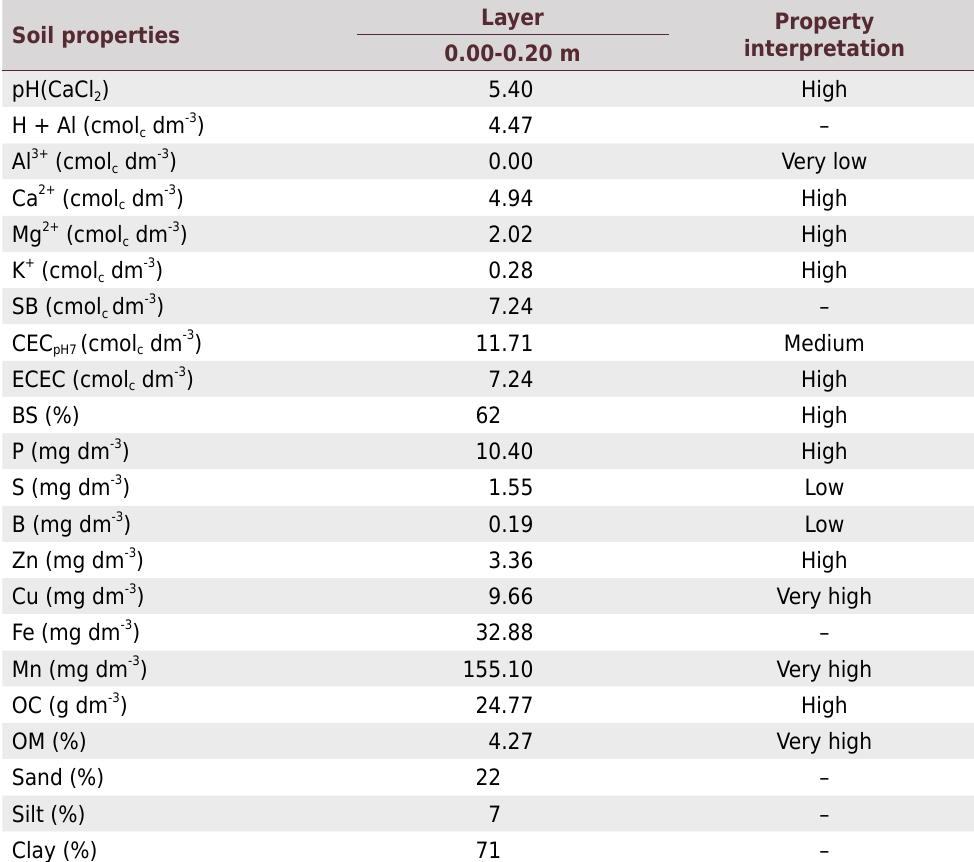
Table 1. Chemical and granulometric analysis of Latossolo Vermelho Distroférrico (Oxisol) and interpretation of values for the surface layer (0.00-0.20 m) according to SBCS/NEPAR (2019) Soil